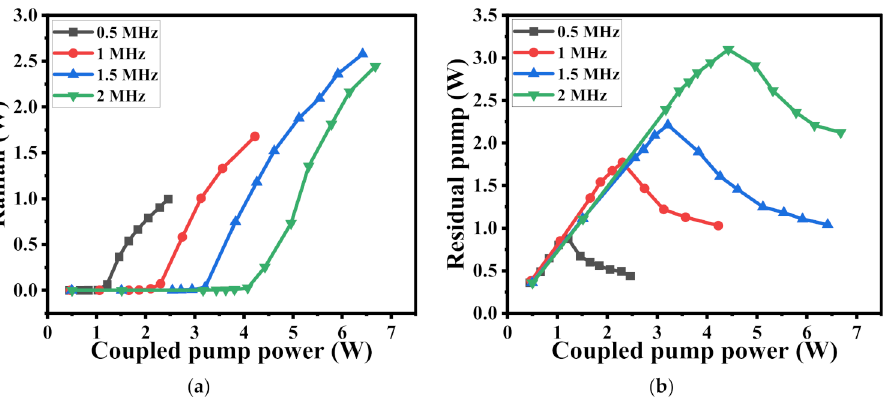
Figure 6. The evolution of ( a ) Raman power and ( b ) residual pump power with respect to the coupled pump power at different repetition frequencies (fiber length of 16.8 m, pressure of 26.5